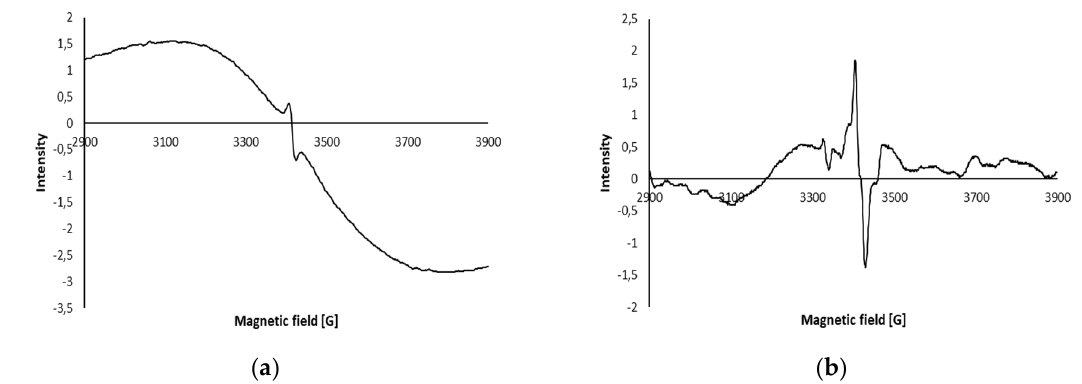
Figure 1. Electronic spin resonance ( ESR) spectrum of original deionized, non-treated water containing dissolved air ( a ) and WTS ( b ) after the 15 min treatment.